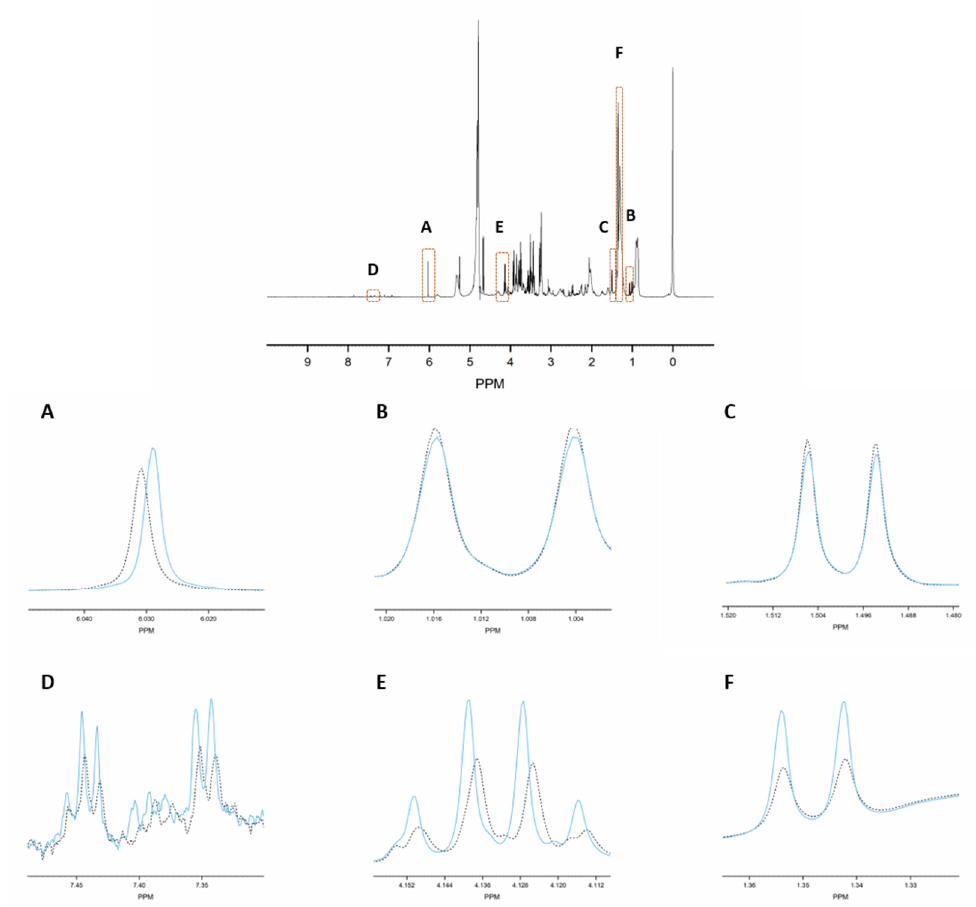
Figure 3. The effect of adding TSP on the chemical shift and intensity of some metabolite signals in human plasma. The human plasma. The signals before addition of TSP (dotted black lines) and after addition of 4 mM signals before addition of TSP (dotted black lines) and after addition of 4 mM TSP (solid blue lines). ( A ): maleic acid; ( B ): TSP (solid blue lines). ( A ): maleic acid; ( B ): valine; ( C ): alanine; ( D ): phenylalanine; ( E , F ): valine; ( C ): alanine; ( D ): phenylalanine; ( E , F ): lactate.